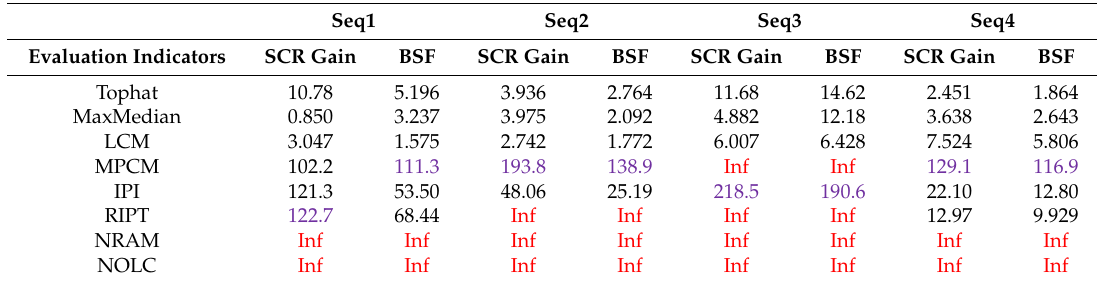
Figure 18. Comparison of processing results for Seq 4 noise images. The variance from top to bottom is 0.01, 0.02, 0.03. (a) Noise image; (b) IPI processing result; (c) RIPT processing result; (d) NRAM processing result; (e) NOLC processing result.